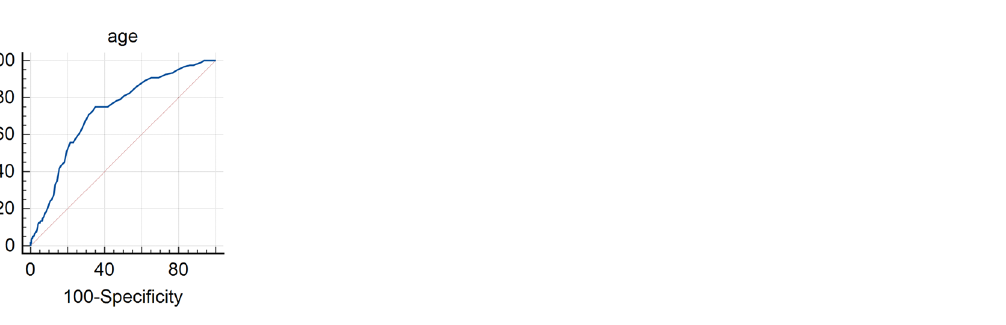
Figure 2. Receiver operating characteristic curve of age for predicting death at hospital discharge. In this figure, the optimal cutoff value of age for predicting survival was over 68 years with a sensitivity of 64.9%, specificity of 75.0%, AUC of 0.723, P-value of < 0.001), and 95% CI of 0.701 to 0.743). AUC, the area under the curve; CI, confidence